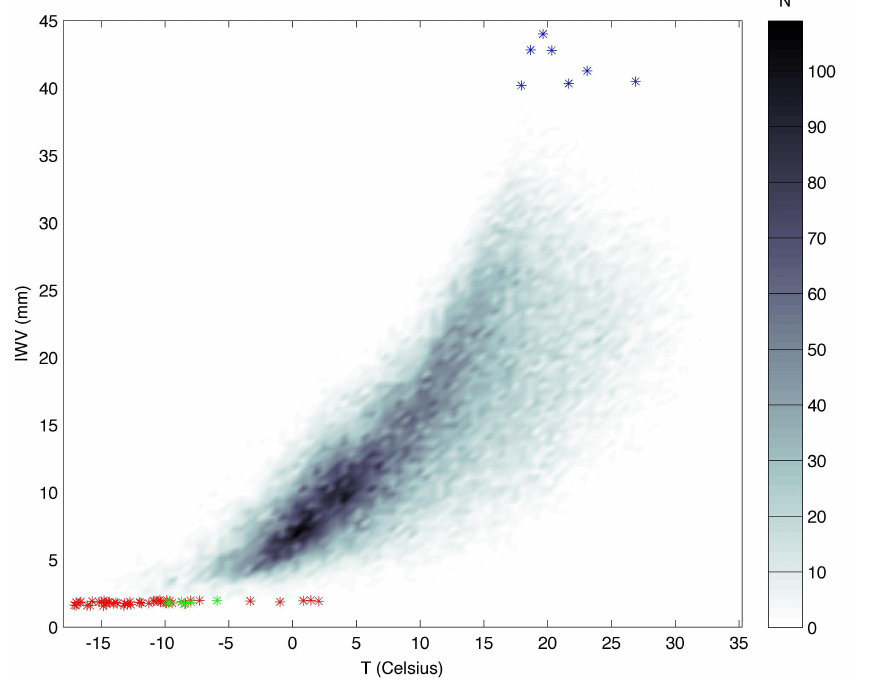
Figure 1. 2D Histogram of IWV and T (temperature at 2 m) for ERA5 data in Bern between January 2009 and December 2021. Extreme values for IWV > 40 mm or IWV < 2 mm are denoted by blue and red stars, respectively. The selected dry event of 13 February 2021 is shown by green